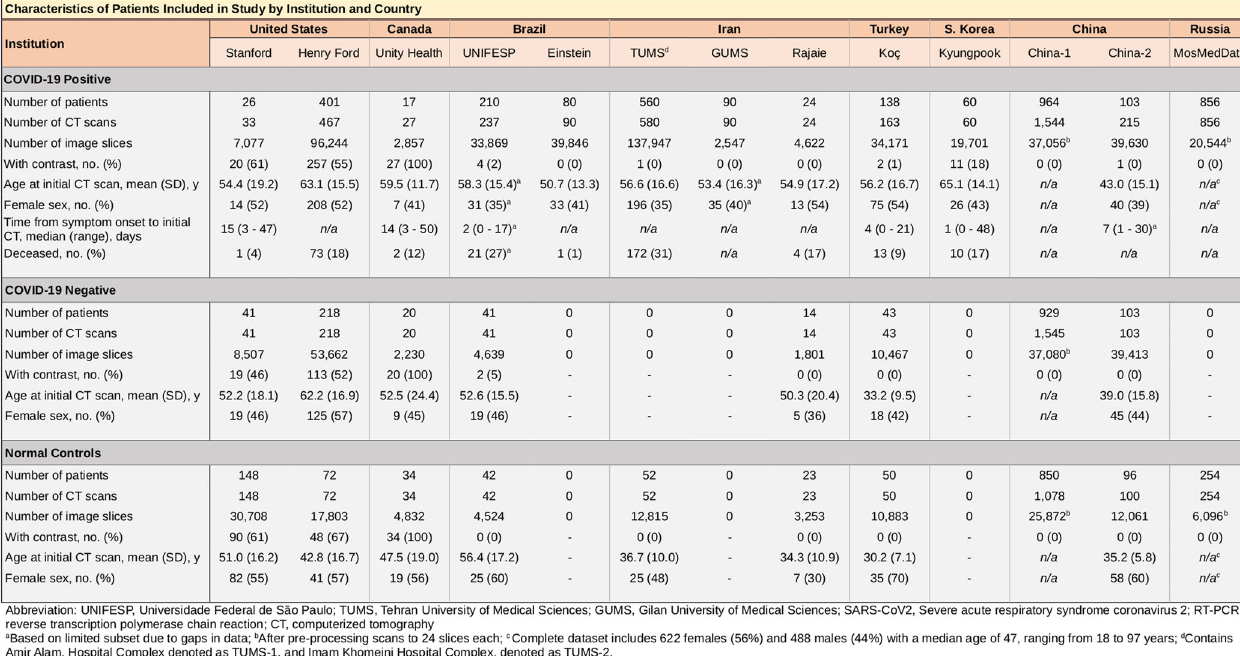
Fig. 2 Characteristics of patients by institution and country. This table summarizes the patient demographics used in our